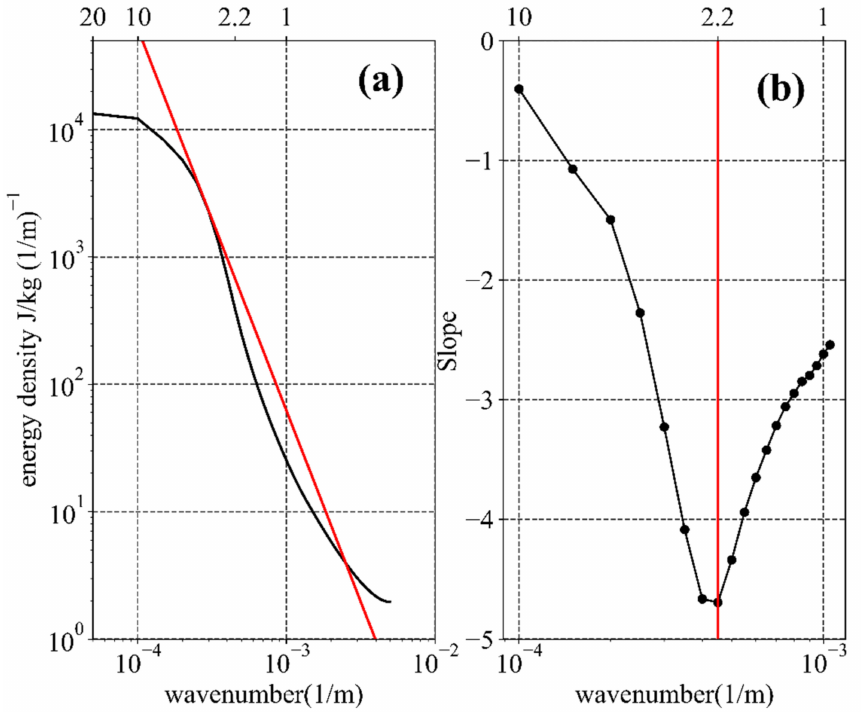
Figure 1. ( a ) Annual mean vertical wavenumber spectra of the GW Ep (black line) and the spectrum with a slope of − 3 (red line). ( b ) Variation in the slope with wavenumber, with the red solid line marking the minimum slope value at a vertical wavenumber of 0.45 km − 1 (wavelength = 2.2 km). The upper coordinate represents the vertical wavelength (unit: